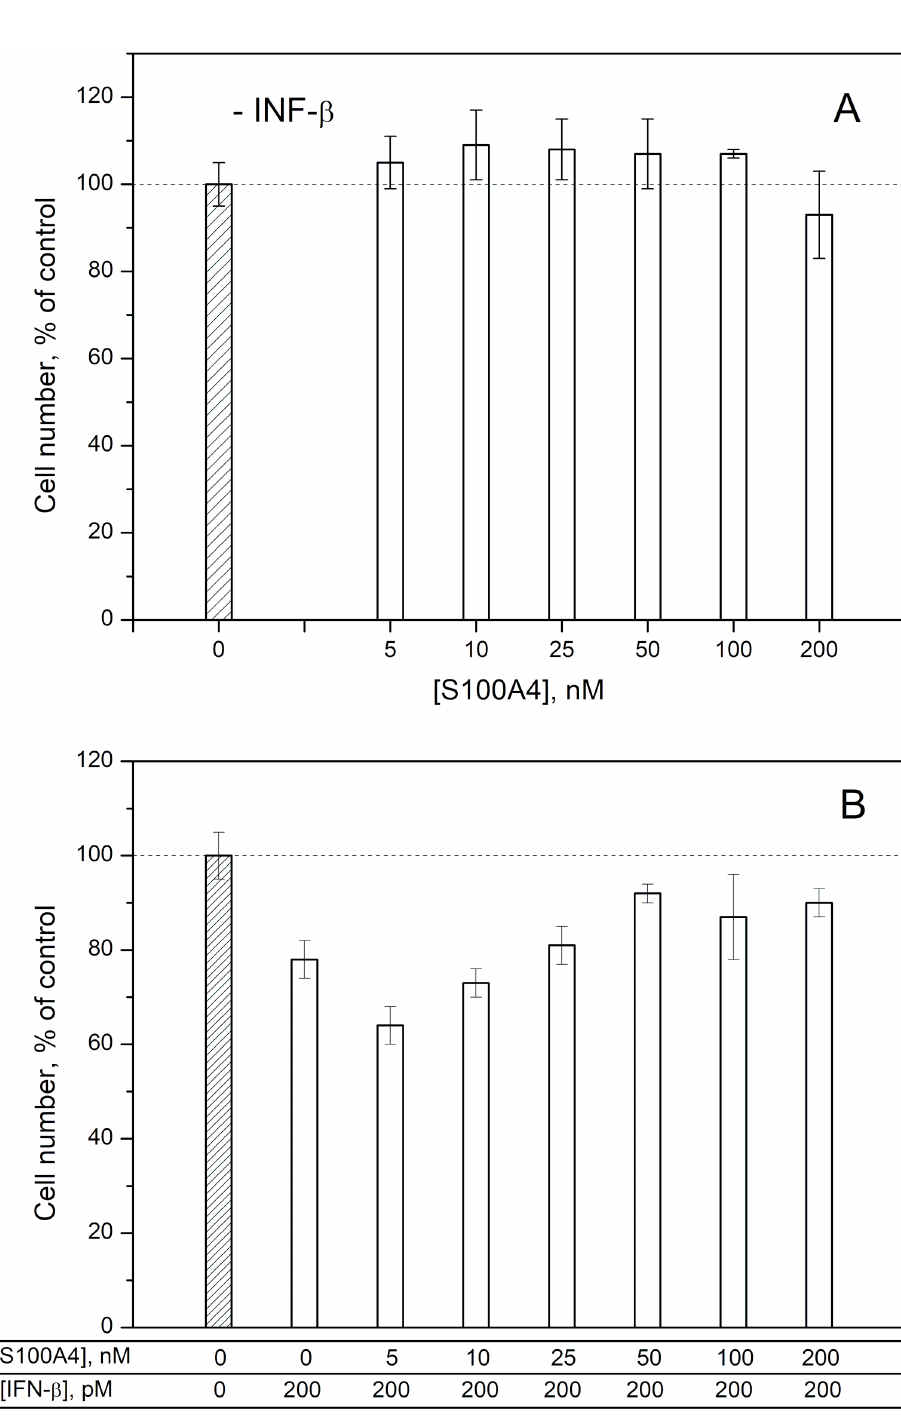
Figure 5. Viability of MCF-7 cells treated by S100A4 protein (panel A ), IFN- β or their combination ( B ) measured by crystal violet assay.